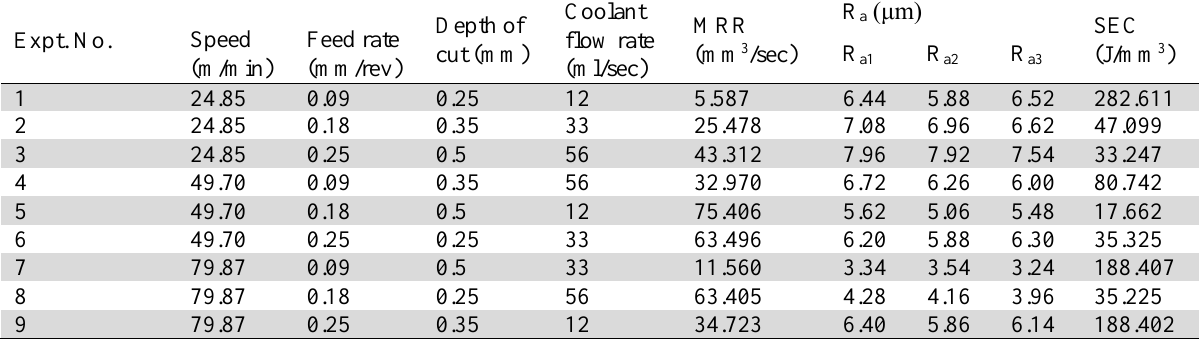
Experimental results Expt. No.